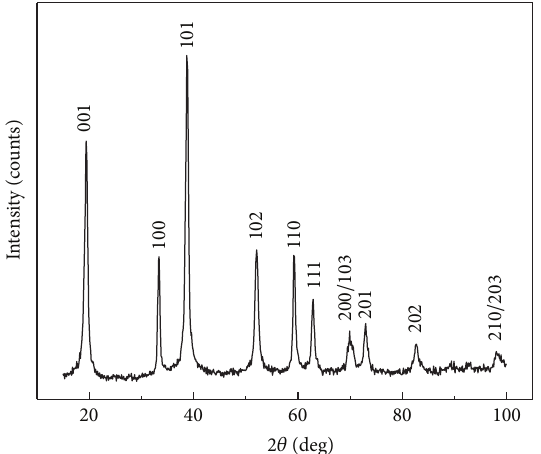
Figure3: XRDpatternofprecipitated nickel hydroxidepowder pro- duced by titrating nickel chloride with hydrazine-sodium hydroxide solution at pH ∼ 10.